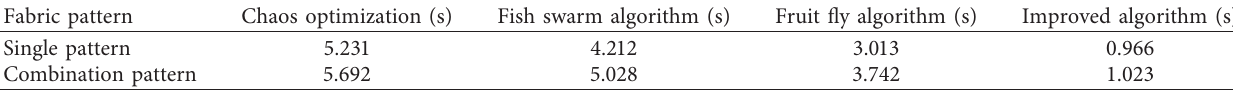
� 204. 3 Table 2: Time comparison of various optimization